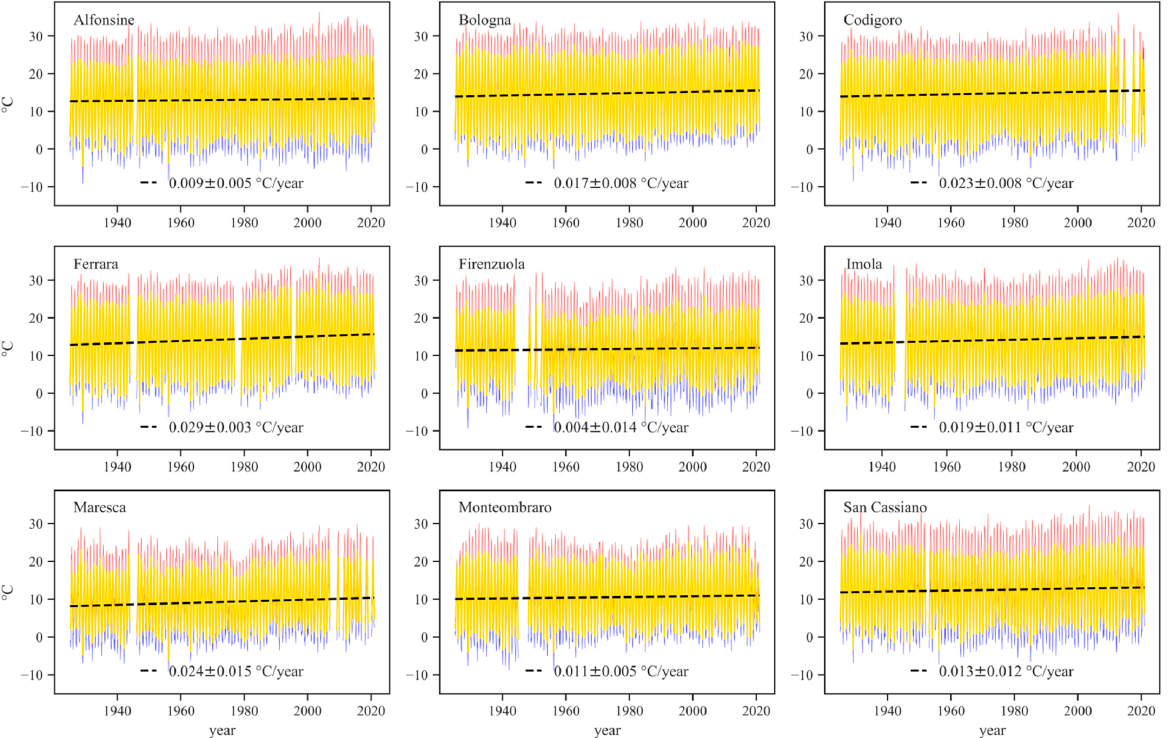
Figure A4. Monthly maximum (red), minimum (blue), and mean (yellow) temperature time series, with estimated linear trends (black dashed line computed over the monthly mean) for the nine stations considered in this